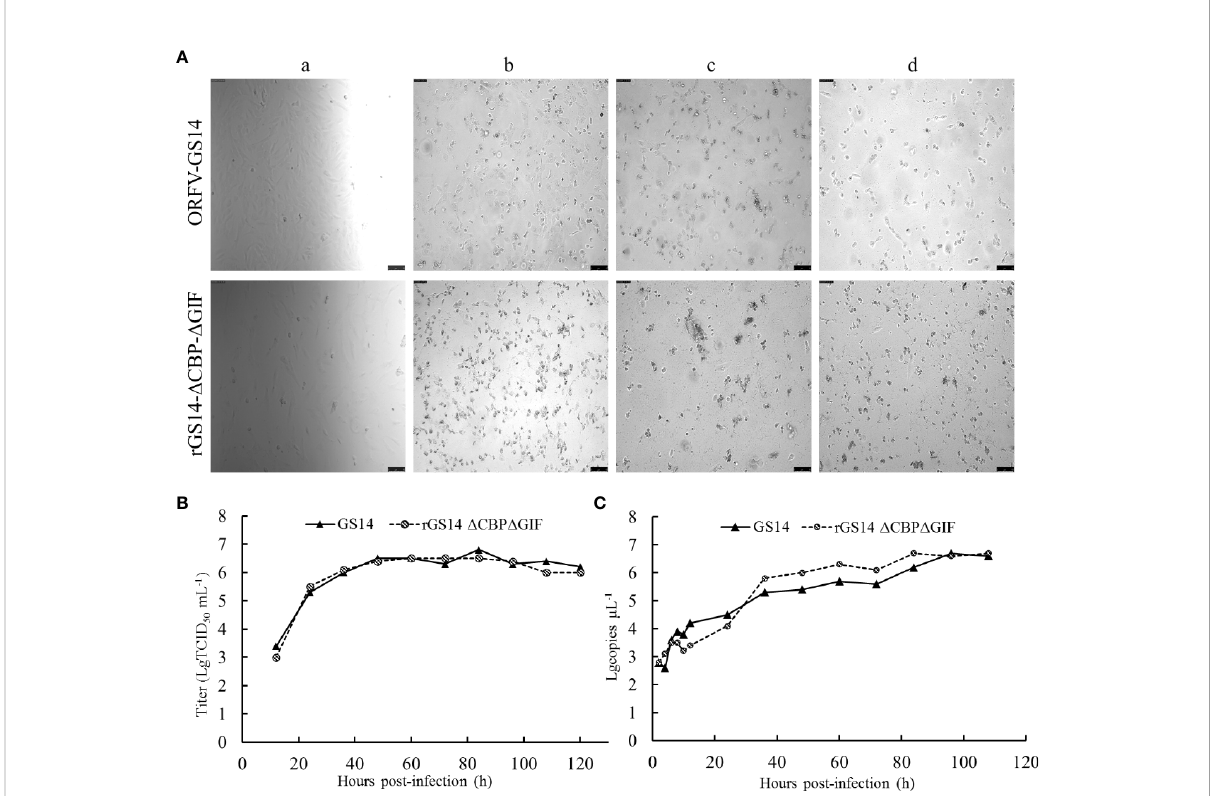
FIGURE 3 Plaque morphology and in vitro replication of rGS14- D CBP- D GIF compared to parental ORFV-GS14. (A) The plaque morphology differences between rGS14- D CBP- D GIF and parental ORFV-GS14 at different time points post-infection. a: 10 h post-infection; b: 48 h post-infection; c: 72 h post-infection; d: 96 h post-infection. (B) Single-step growth curve (MOI = 1) of rGS14- D CBP- D GIF in PGT cells. (C) Virus quantity of rGS14- D CBP- D GIF in PGT cells at different time points post-infection. The copy numbers of the virus at different time points post-infection were determined by real-time quantitative PCR. Results were calculated based on two independent